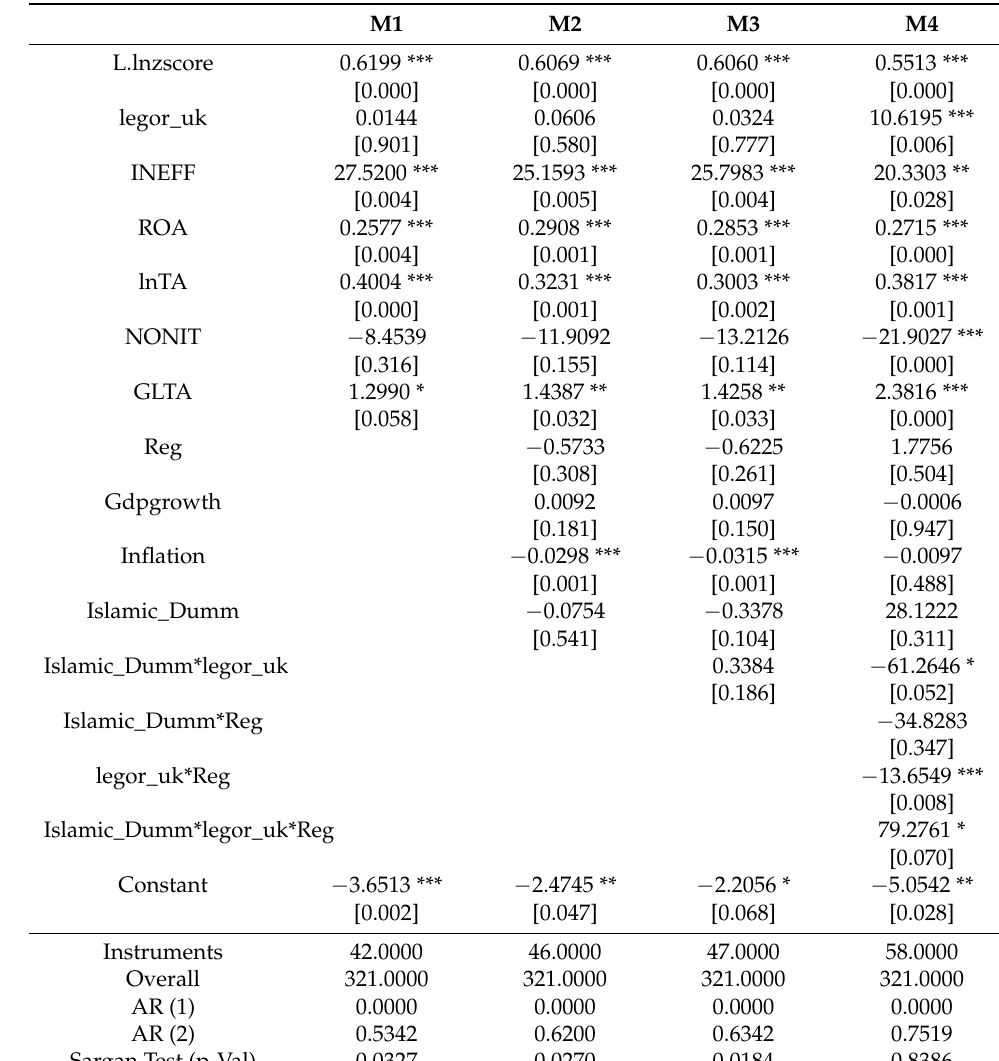
Table 9. Robustness: Banks’ risk-taking and legal